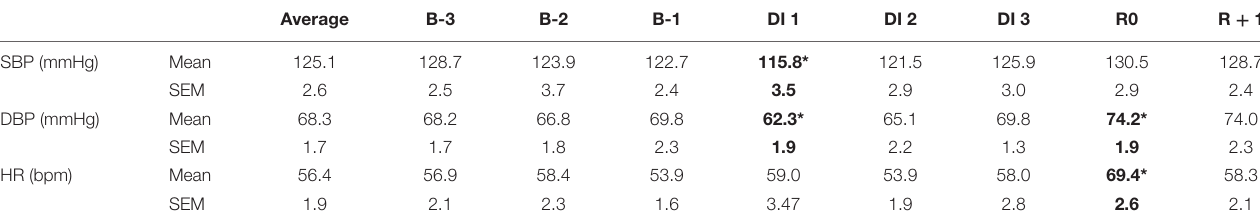
TABLE 3 | Blood pressure and heart rate before, during, and after the 3-day dry immersion (DI) at 7 pm. Average B-3 B-2 B-1 DI 1 DI 2 DI 3 R0 R + 1 SBP (mmHg) Mean 125.1